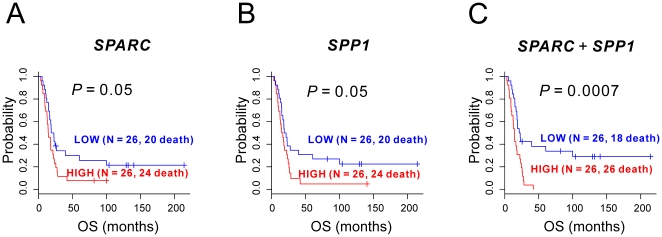
Kaplan-Meier plots of overall survival for EAC patients.(A) Overall survival by SPARC status in 52 patients. (B) Overall survival by SPP1 status in 52 patients. (C) Overall survival by SPARC+SPP1 in 52 patients.